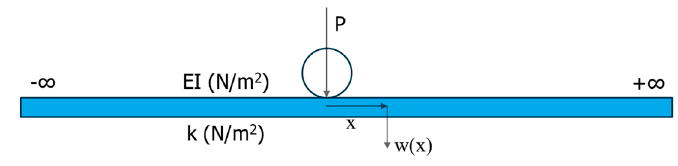
Figure 8. Beam on elastic foundation model.